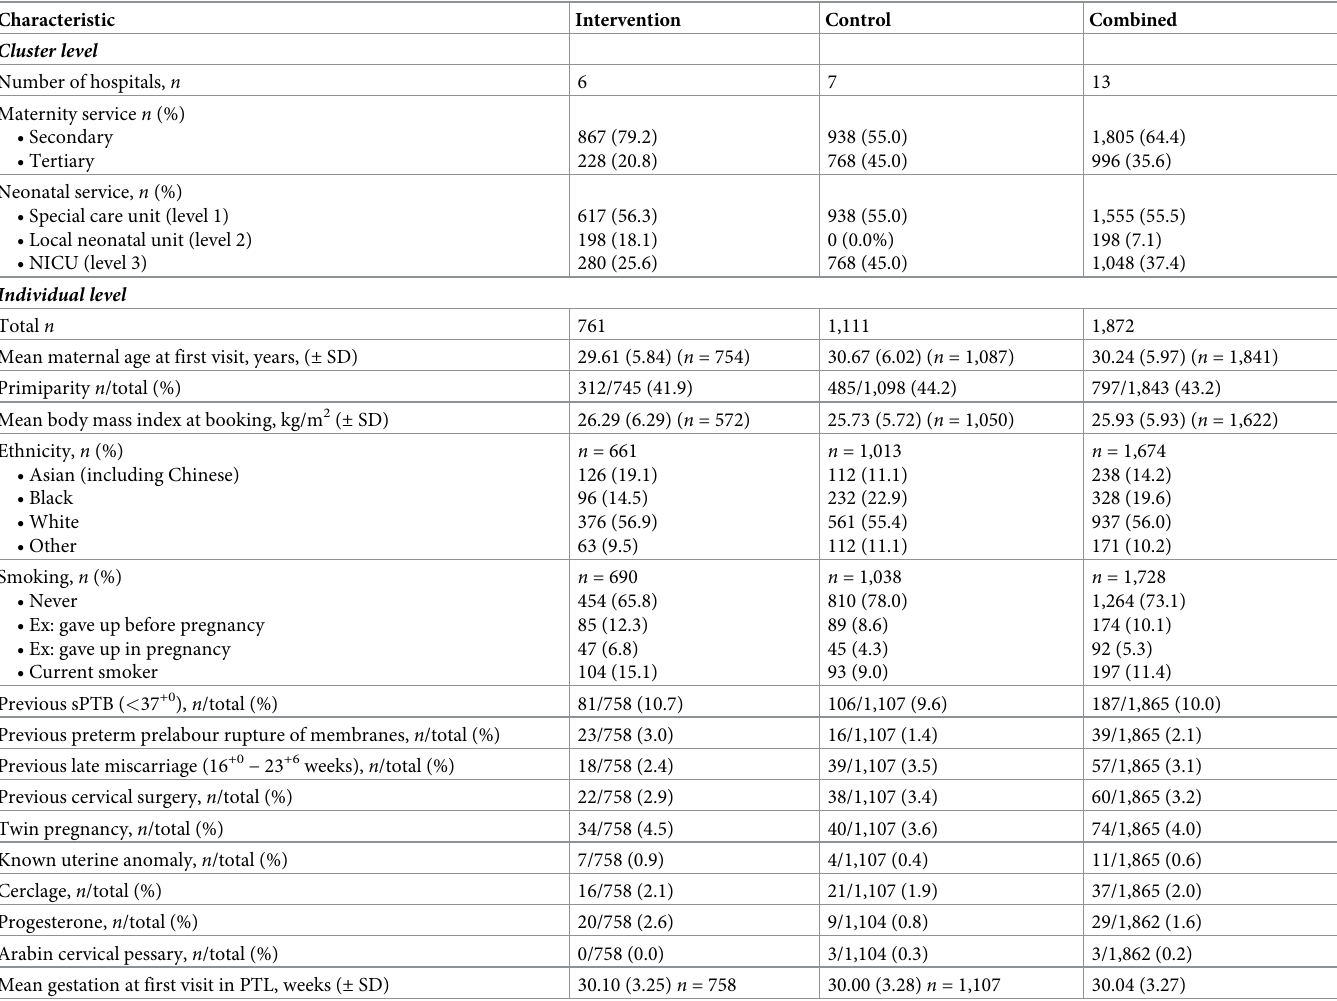
Table 1. Baseline characteristics of clusters and women in intervention sites using QUiPP app versus control sites ( n = 1,872).